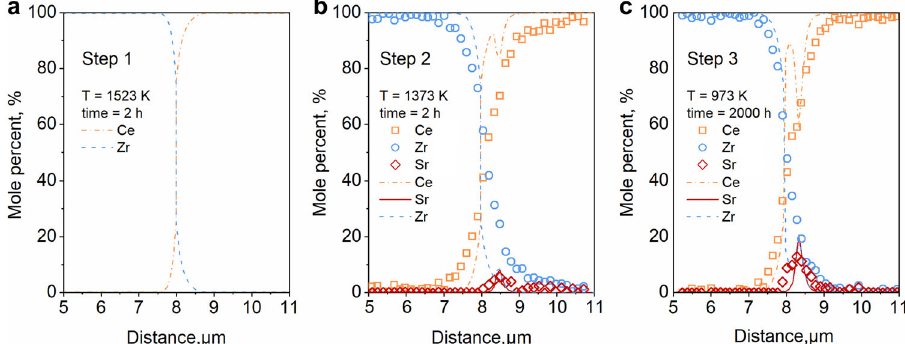
Fig. 2 Composition pro fi les across the oxygen electrode – electrolyte interface (screen-printed CGO). Simulated composition pro fi les (dotted lines) in comparison with previous experimental data (scattered symbols) 24 , for the case of a SOFC with screen-printed CGO barrier layer during the different steps in ( a , b ) cell production and ( c ) long-term operation. The distance at 0 μ m corresponds to the left boundary of the ZrO 2 layer, and the original ZrO 2 – CeO 2 interface is located at 8 μ m.